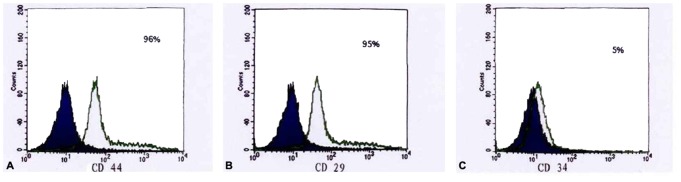
Identification of Rabbit BMMSCs.(A–C) The results of FACS respectively showed that 96% of the third-generation cells expressed CD44 and 95% of the cells expressed CD29, while only 5% of the cells expressed CD34.